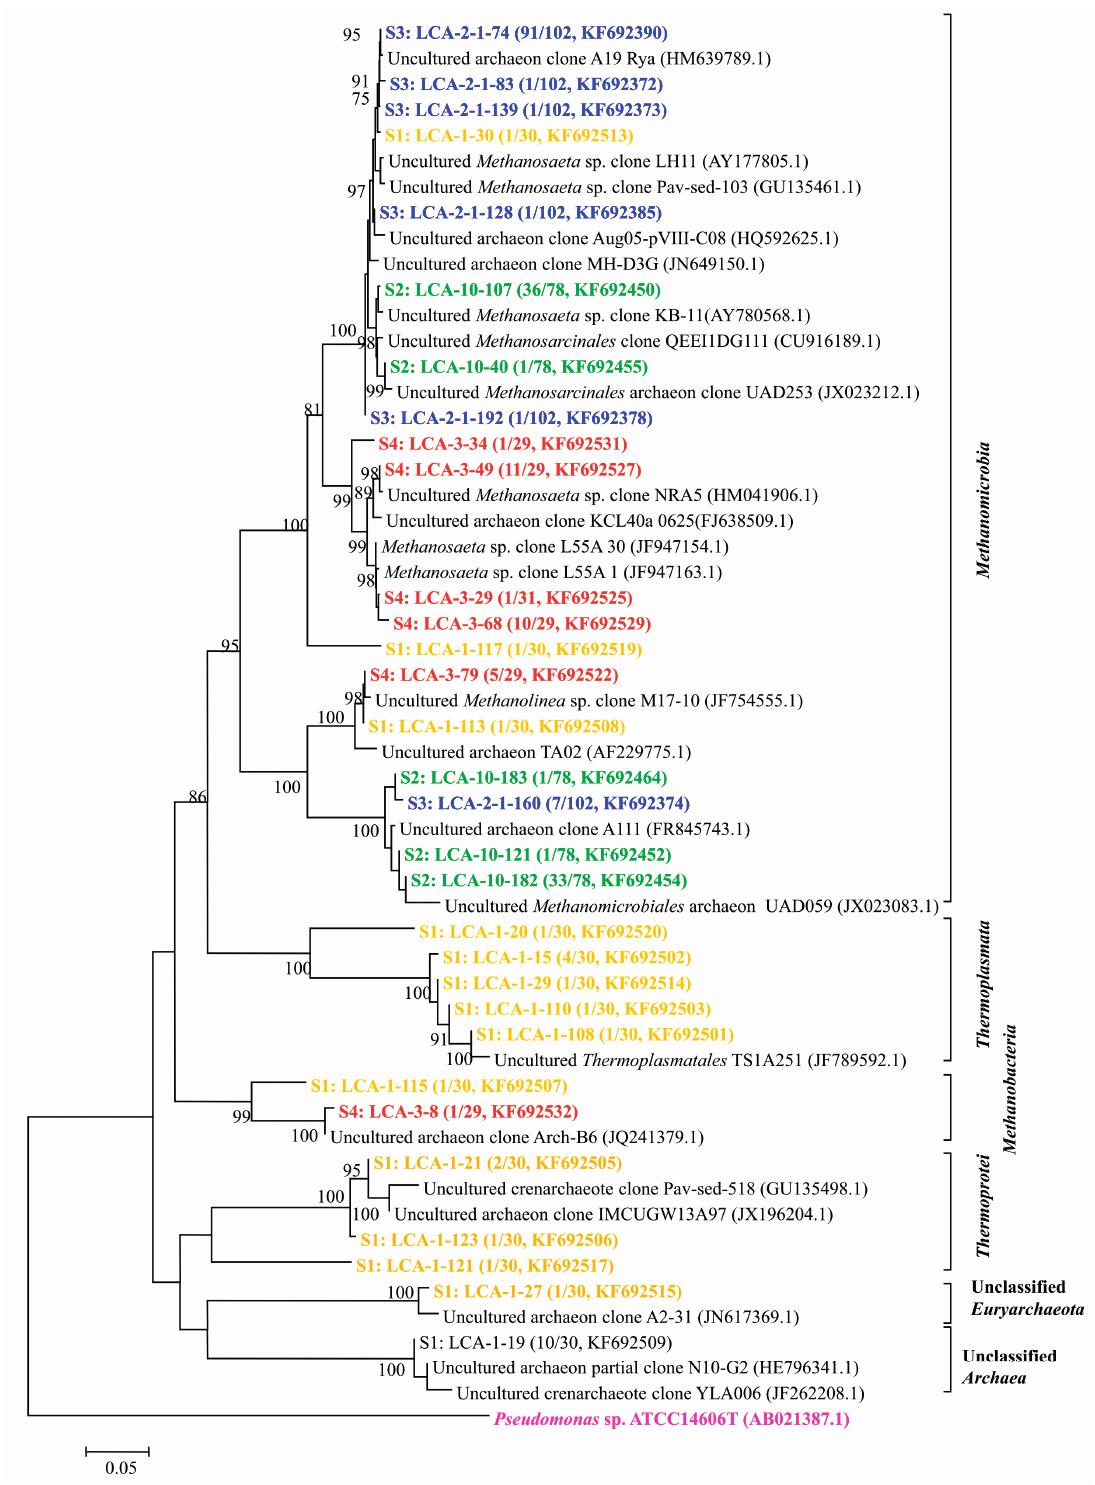
Figure 4. Phylogenetic tree of archaeal clones from the samples of S1–S4 showing the distributions of OTUs and closely related sequences from GenBank database. The bootstrap values at the nodes of ≥ 75% ( n = 1000 replicates) are reported. The scale bar represents 5% sequences divergence. The numbers in parentheses indicate the frequencies of appearance of identical clones in the total analyzed clones followed with the accession number. Pseudomonas sp. clone ATCC14606 was used as